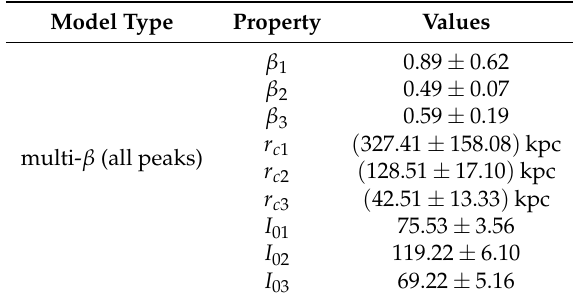
Figure 6. A520 photon map. This shows the smoothed photon map distribution ( a ) and the fitting of the 2D projection of the photon map distribution along the x -axis ( b ) with the fitting curve (black dotted curve). Table 2. Values of parameters obtained from the fitting in Figure